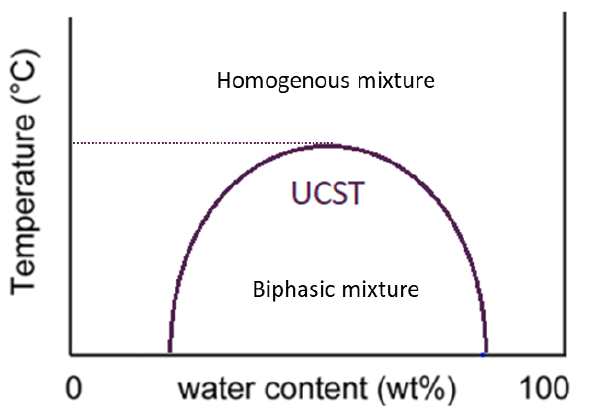
Figure 1. Schematic overview of liquid-liquid phase diagram of IL/water systems with a UCST.